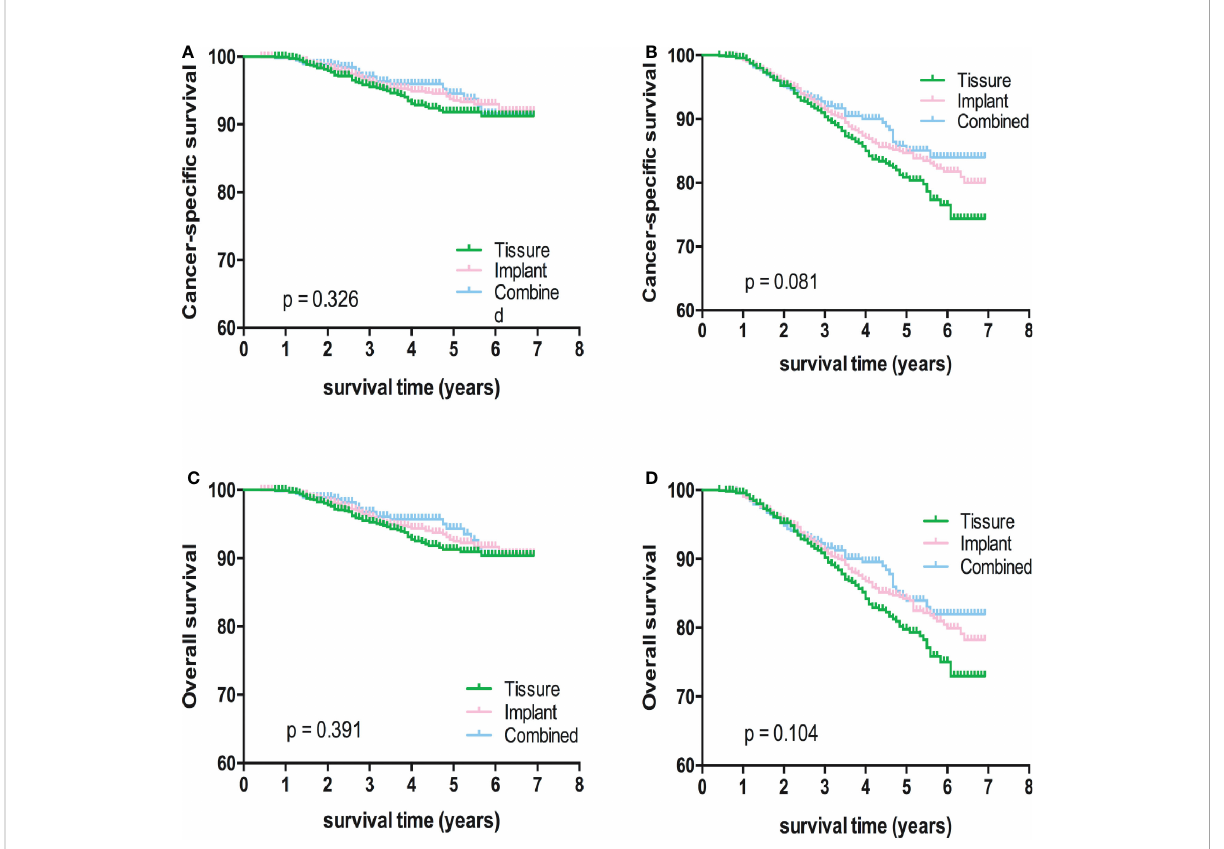
FIGURE 3 Kaplan-Meier analyses of CSS (A, B) and OS (C, D) among patients with I/II or III/IV stage strati fi ed according to reconstructive